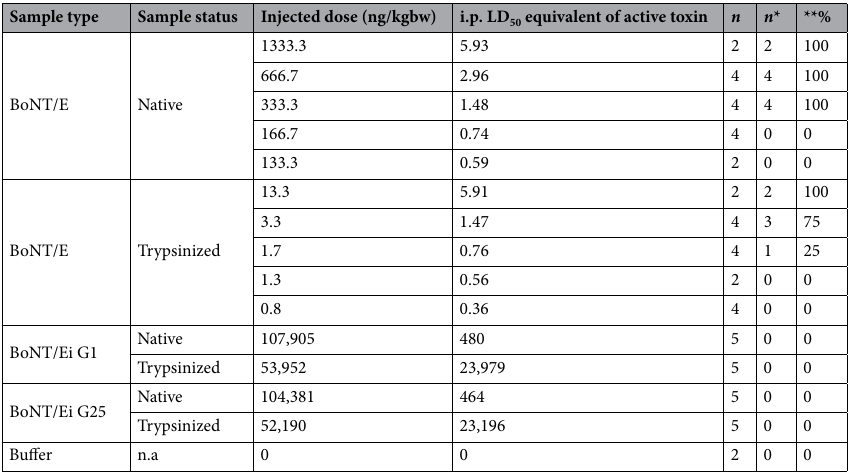
Table 1. Detection of the activity of wild-type and inactive botulinum neurotoxin type E (BoNT/E and BoNT/ Ei, respectively) using the mouse bioassay. n.a. not applicable, n number of animals used; n* number of deaths, **%, percent of